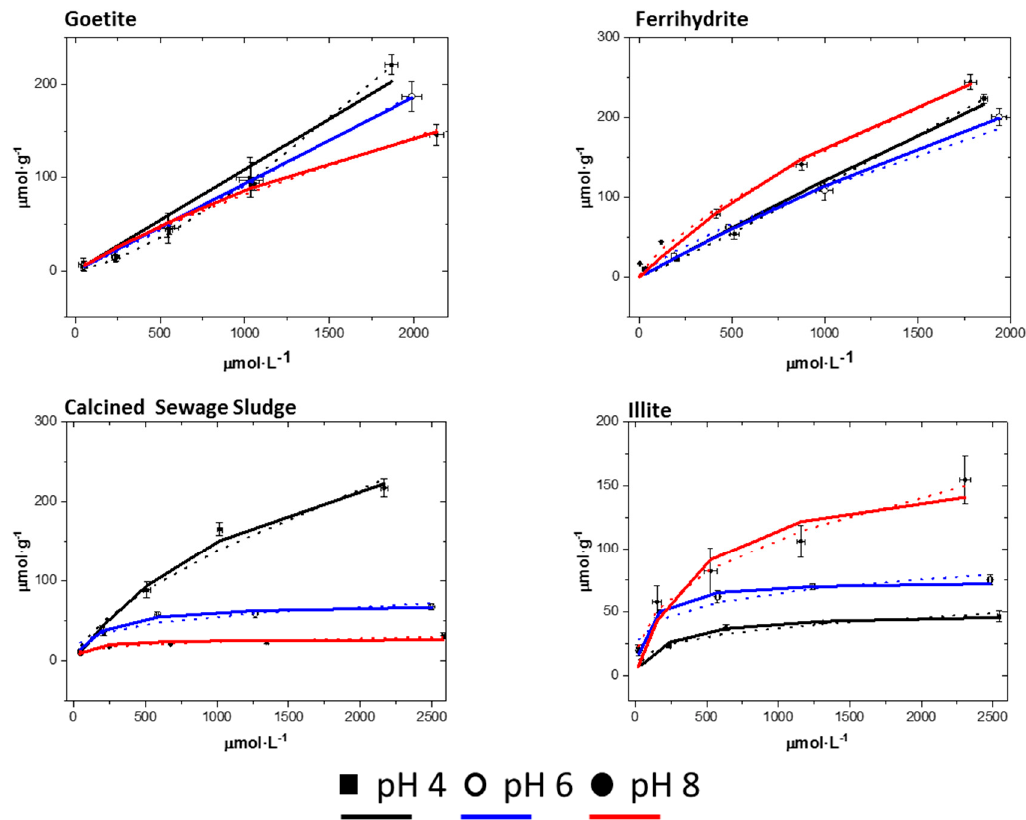
Figure 9. pH dependence of TC adsorption isotherms for iron hydroxides, calcined sewage sludge and illite at 25 °C in 0.1 M of NaCl aqueous media. pH = 4 in black; pH = 6 in blue; pH = 8 in red. Solid lines correspond to Langmuir fit. The Freundlich model fitting is plotted as dots. Freundlich and Langmuir models are inserted for comparison. Fitting parameters are listed in Table 3 (Freundlich) and Table 4 (Langmuir).